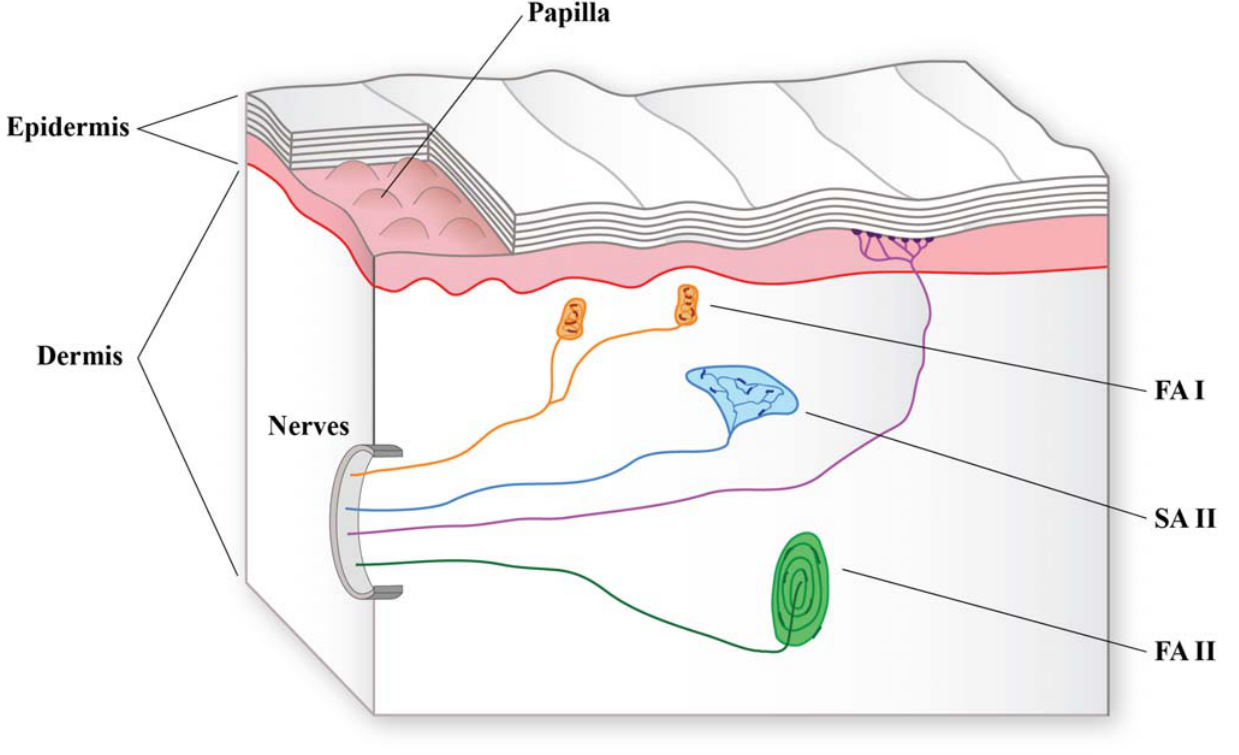
Figure 1. Section of the glabrous human skin illustrating the main classes of mechanoreceptors, comprising SA I (Merkel cells), FA I (Meissner corpuscles), SA II (Ruffini endings) and FA II (Pacinian corpuscles) tactile units (also, see Table 1).